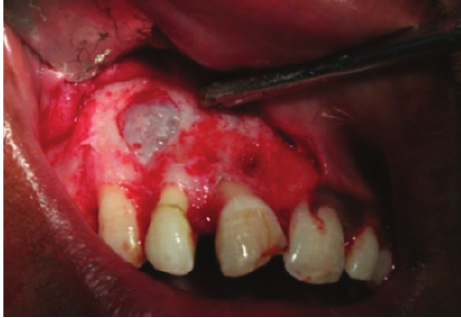
Figure 38: Lesional tissue stored in